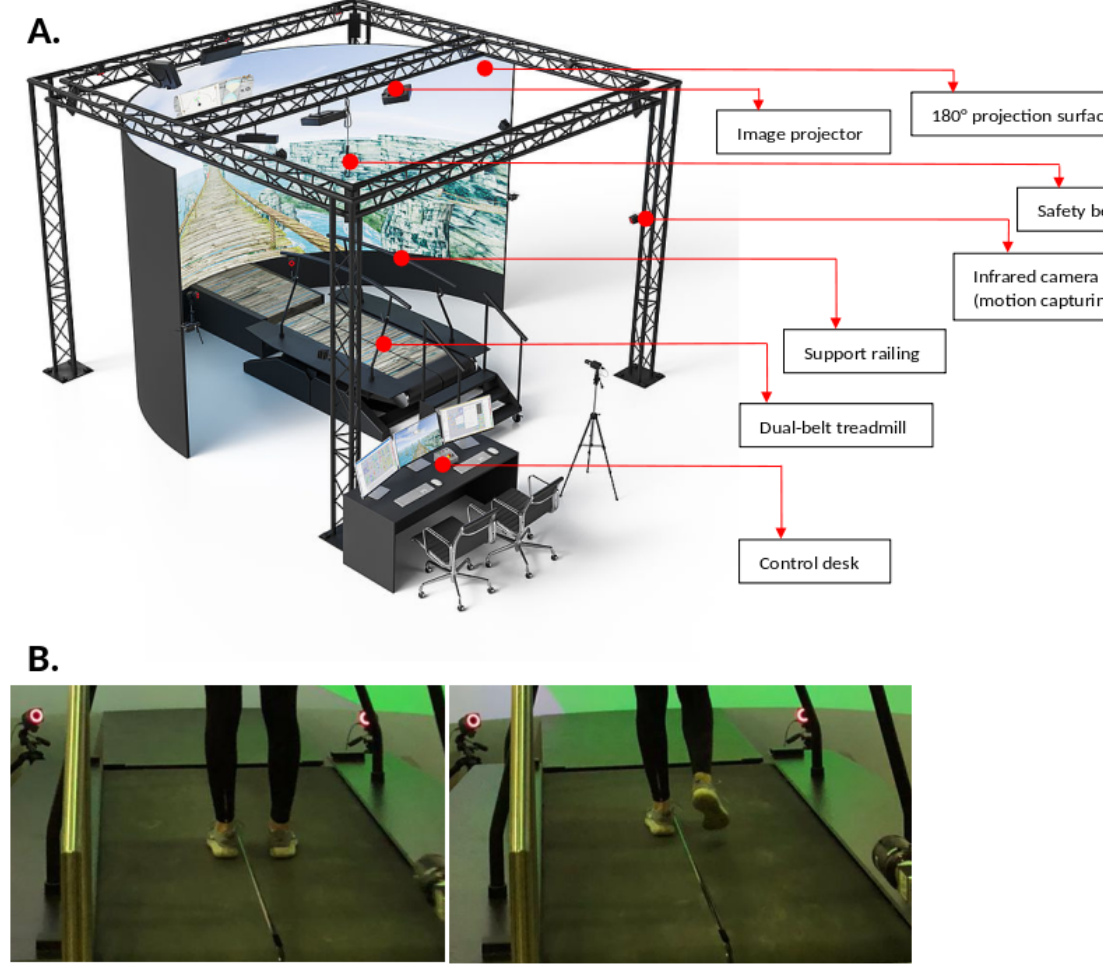
Figure 1. (A) The GRAIL system, consisting of a dual-belt treadmill, 180° projection surface, and optical motion capturing system (figure sourced from Motek Medical); (B) plantar